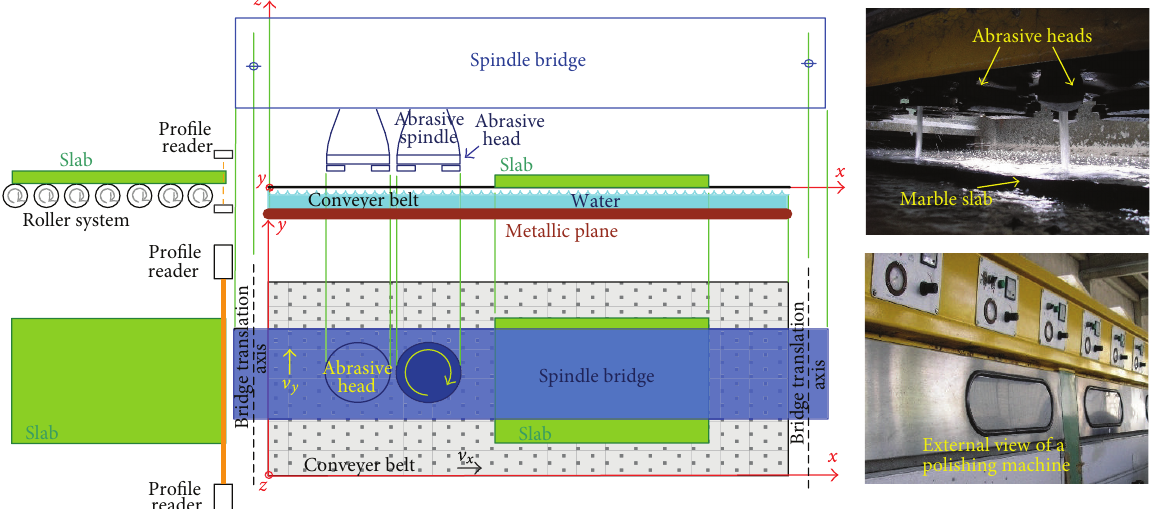
F 1: Schematic diagram of a marble machine and a snapshot of the abrasive heads over a marble slab.